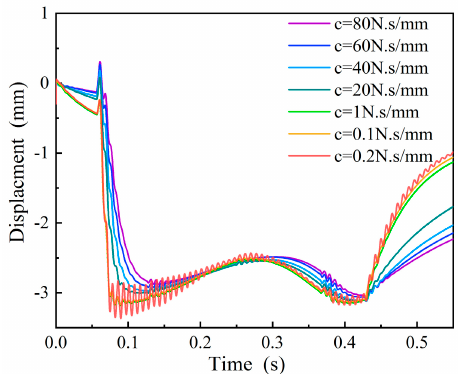
Figure 7. The motion states of the measuring ruler with different damping coefficients.